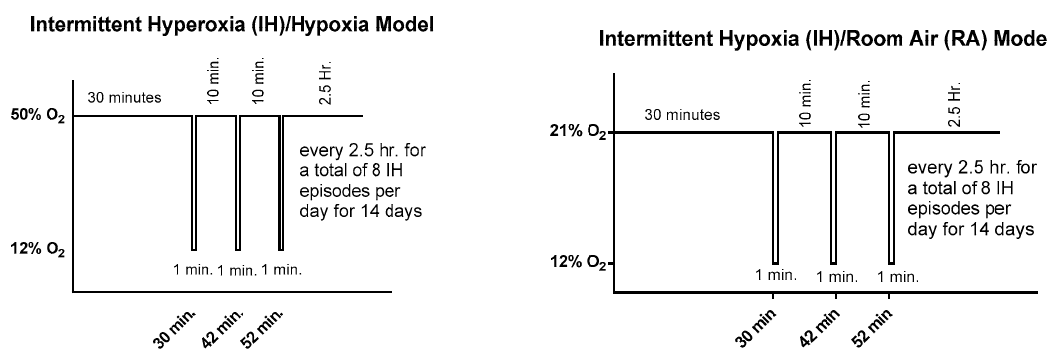
Figure 1. Representation of the two neonatal intermittent hypoxia (IH) paradigms used in this study. Hyperoxia (50% O 2 ) following a brief, repetitive hypoxic event (12% O 2 ) is presented in ( A ).